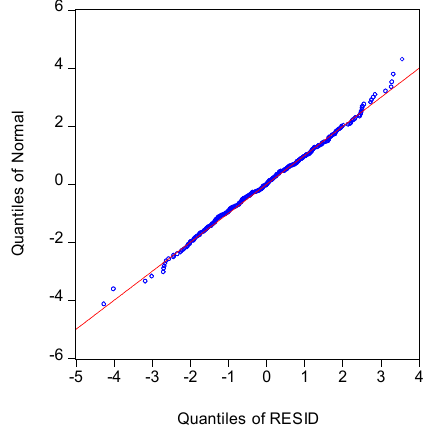
Figure 5. Depicting through the normal probability plot of